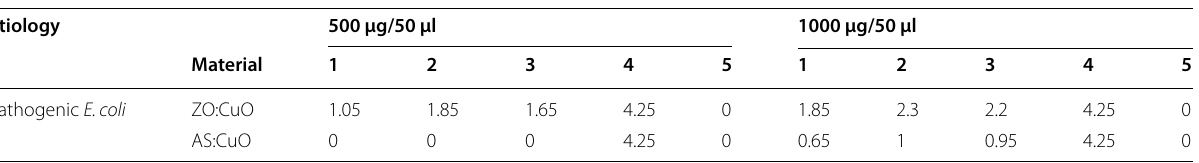
Table 1 Bactericidal